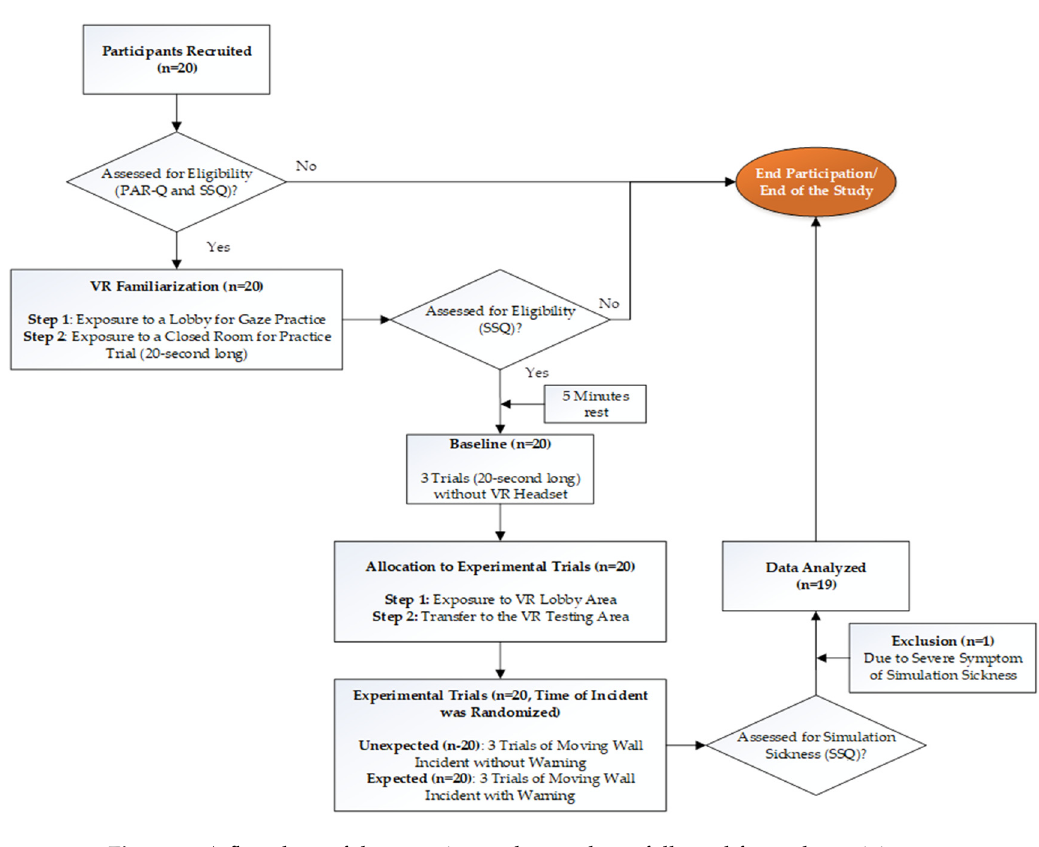
Figure 1. A flowchart of the experimental procedures followed for each participant.